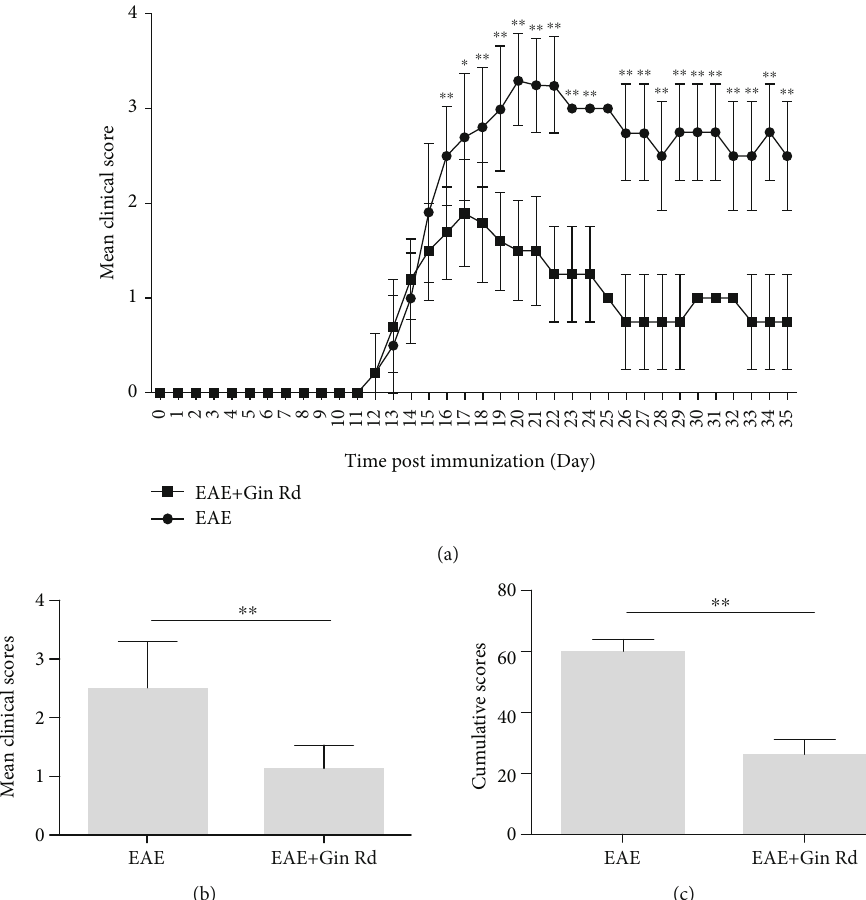
Figure 1: Treatment with Ginsenoside Rd ameliorated the clinical severity of experimental autoimmune encephalomyelitis (EAE) mice. Following immunization and treatment with Ginsenoside Rd, daily clinical scores of EAE mice with or without Ginsenoside Rd treatment were recorded over the course of the 35-day experiment: (a) daily clinical scores of EAE mice with or without Ginsenoside Rd treatment; (b) mean clinical scores of EAE mice with or without Ginsenoside Rd treatment; (c) cumulative clinical scores of EAE mice with or without Ginsenoside Rd treatment. ∗ P < 0 : 05 , ∗∗ P < 0 : 01 vs. EAE group. Gin Rd: Ginsenoside